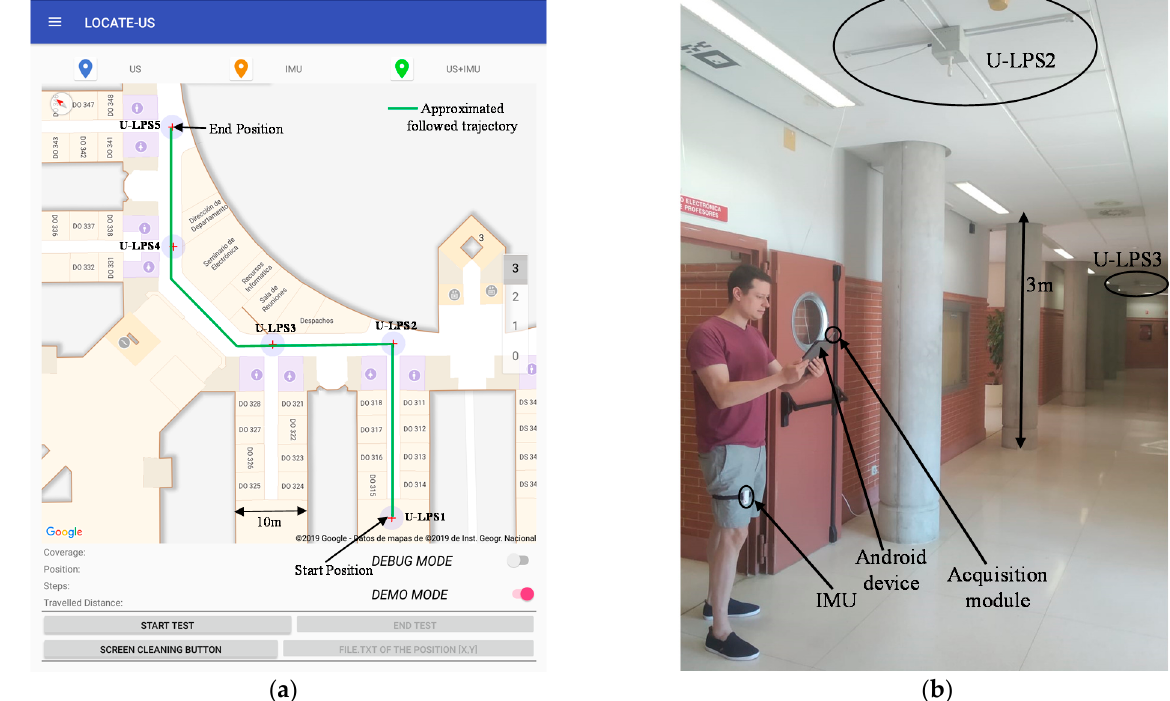
Figure 18. ( a ) Indoor map with the U-LPS positions and the trajectory followed by the user (in the real experiments users try to carefully follow it). ( b ) General view of the experimental setup with a person equipped with an Android device connected to the acquisition module and the IMU installed outside the pocket of the